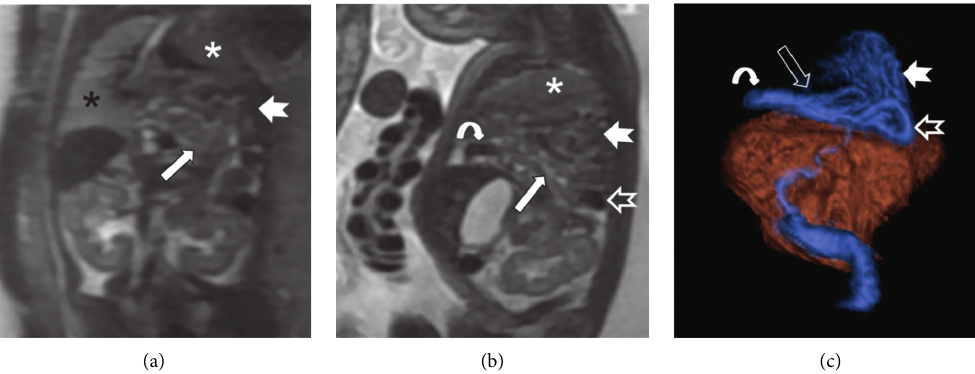
Figure 5: Left diaphragmatic hernia. Gestational age: 27 weeks and 6 days. (a) Coronal SSFSE T2. (b) Sagittal SSFSE T2. (c) Volume rendering coronal reconstruction. Complete herniation of jejunal (solid white arrow) and ileal (solid white arrowhead) loops is observed. Herniation of the hepatic angle of the colon (curved white arrow), ascending colon and cecum (empty white arrow) is also observed, and they are located above the splenic angle of the colon (empty white arrowhead). The left lung is hypoplastic and is collapsed in the left upper hemithorax (white asterisk). The cardiomediastenic displacement towards the right hemithorax and normal right lung (black asterisk) is shown. No hepatic or gastric herniation is observed. Relative pulmonary volume is 72.64%; the intensity ratio of the pulmonary parenchyma relative to the hepatic parenchyma is > 1 and the intensity ratio of the pulmonary parenchyma in relation to the CSF is 0.78, implying a good